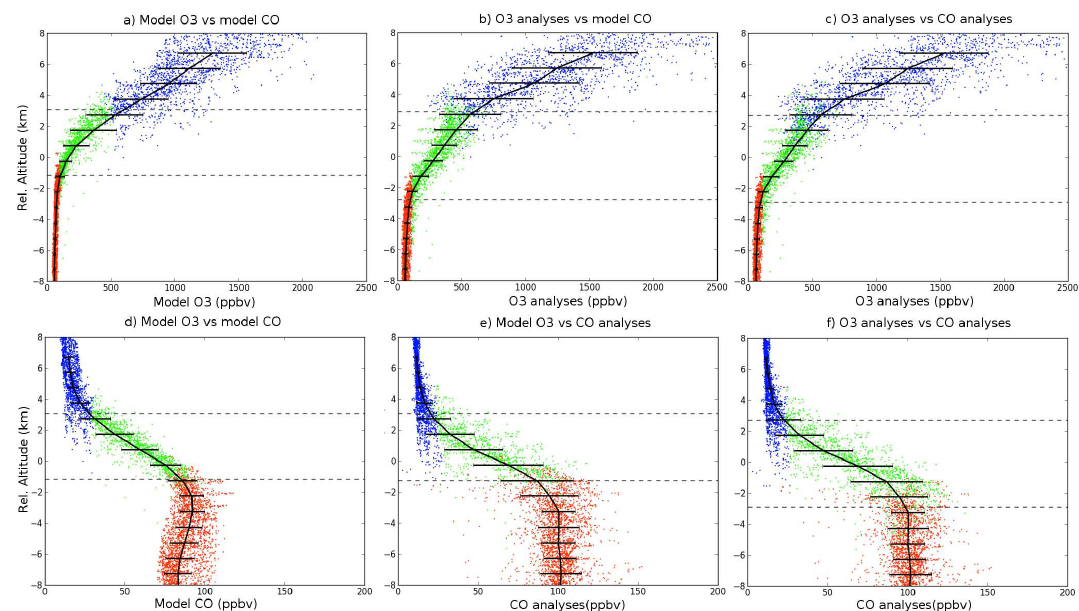
Fig. 4. O 3 and CO profiles in the region between 30 ◦ W–10 ◦ E and 40–65 ◦ N on 15 August 2007 at 12:00UTC. O 3 profiles (ppbv) in altitude coordinates (km) relative to the 360K level are provided for model O 3 vs. model CO (a) , O 3 analyses vs. model CO (b) and O 3 analyses vs. CO analyses (c) . CO profiles (ppbv) in relative altitude coordinates (km) are provided for model O 3 vs. model CO (d) , model O 3 vs. CO analyses (e) and O 3 analyses vs. CO analyses (f) . Following selection criteria, red and blue dots are identified as of tropospheric and stratospheric origin, respectively. The green dots are identified as the transitional layer between the stratosphere and the troposphere (see text for details). Black lines represent the mean profile every kilometer, and horizontal error bars show the 1 σ standard